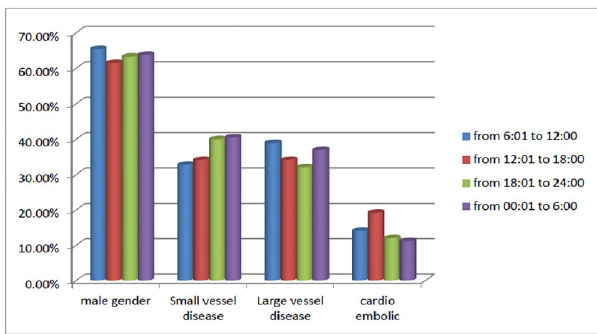
Fig 2. Characteristics of patients according to time of stroke